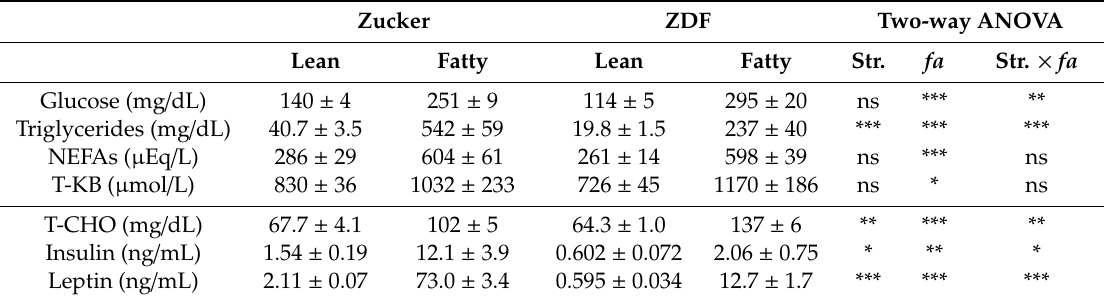
Table 2. Biochemical analysis of blood serum. Zucker ZDF Two-way ANOVA Lean Fatty Lean Fatty Str. Str. × fa Triglycerides (mg / dL)